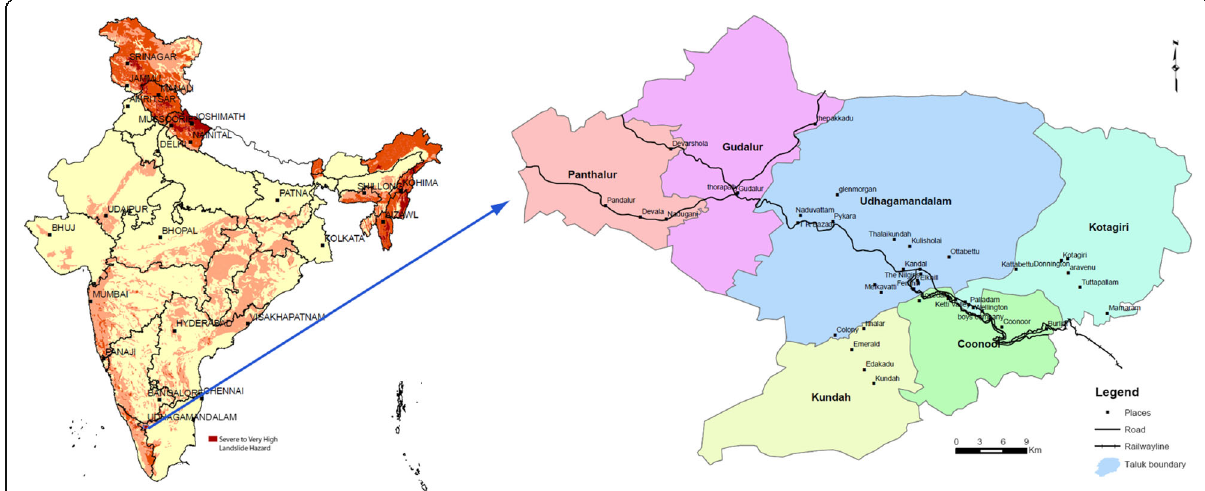
Fig. 1. Location map of the study area on the landslide hazard zonation map of